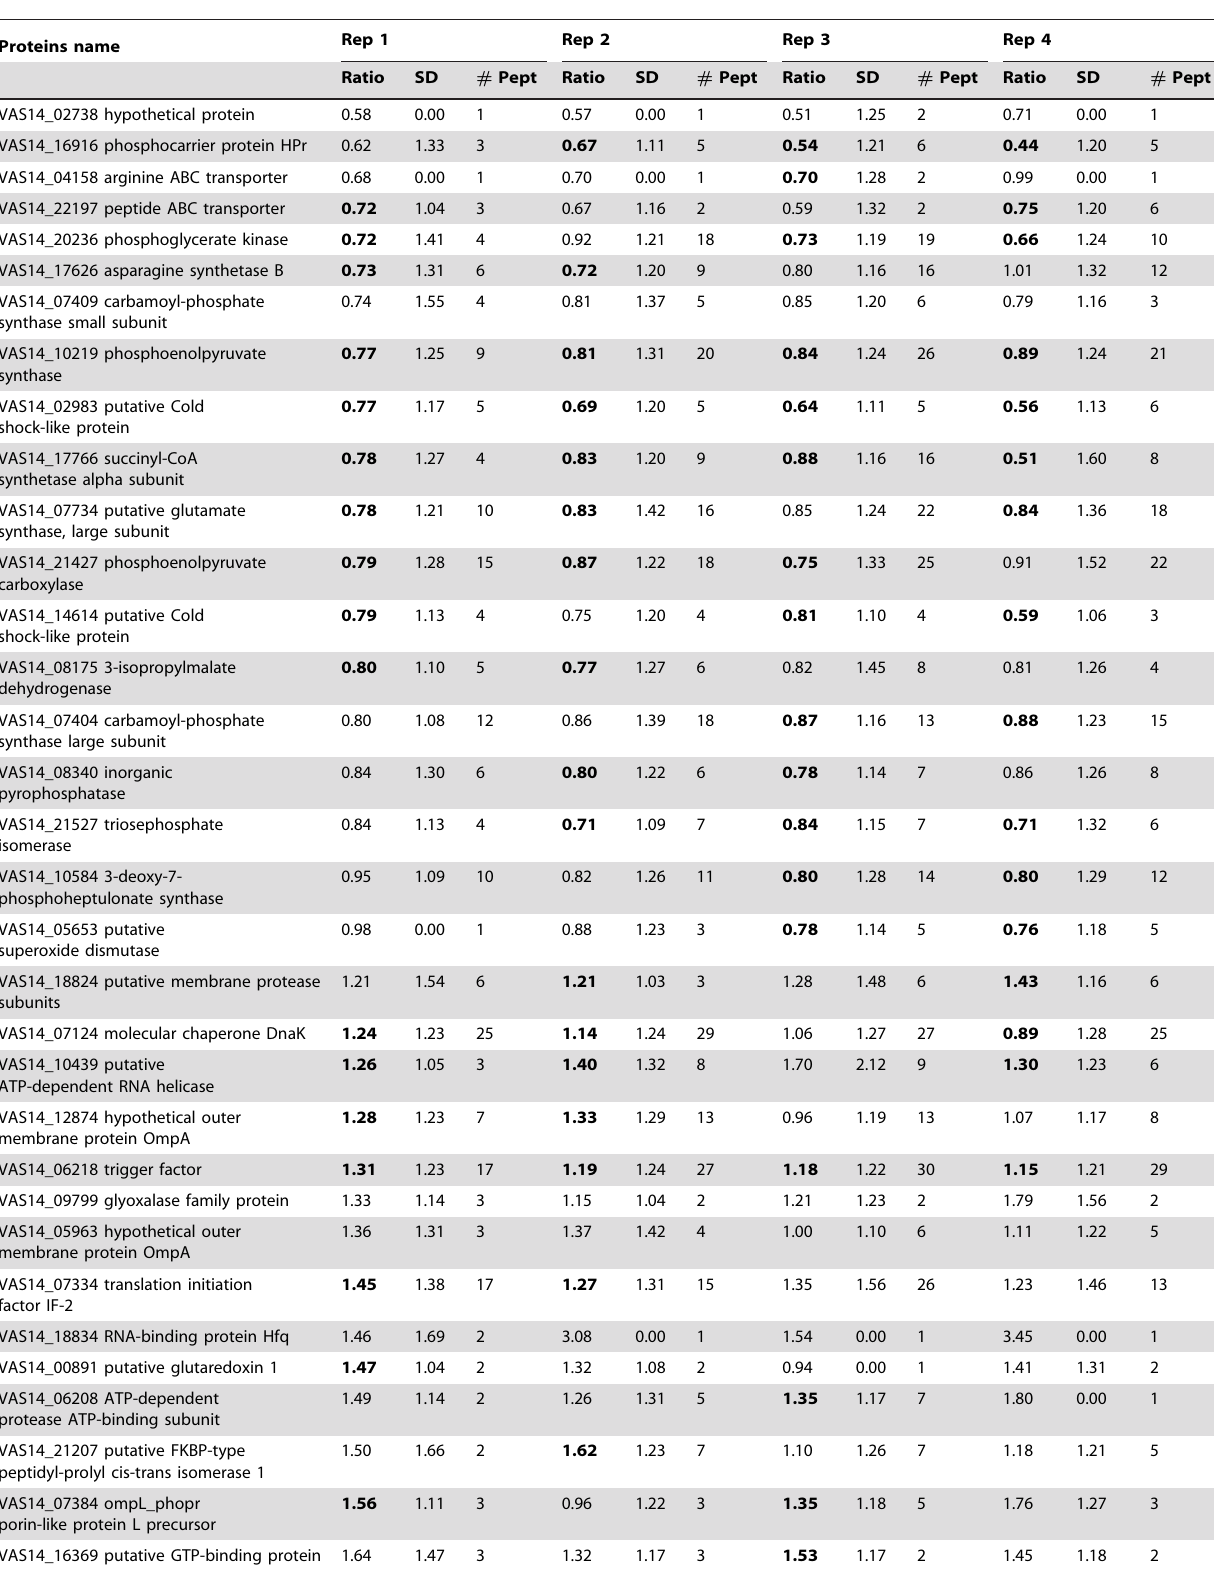
Table 1. List of the quantified proteins in four biological replicates using the post-digest ICPL labeling methodology.